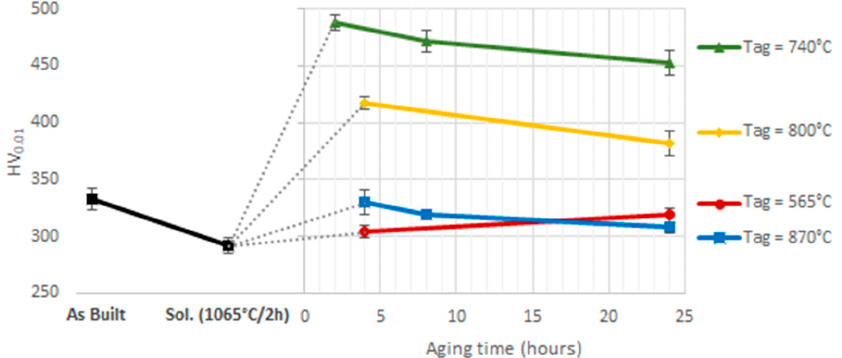
Figure 19. Vickers microhardness at different heat treatment conditions (as-built, solutioning, and aging at different temperatures and times).